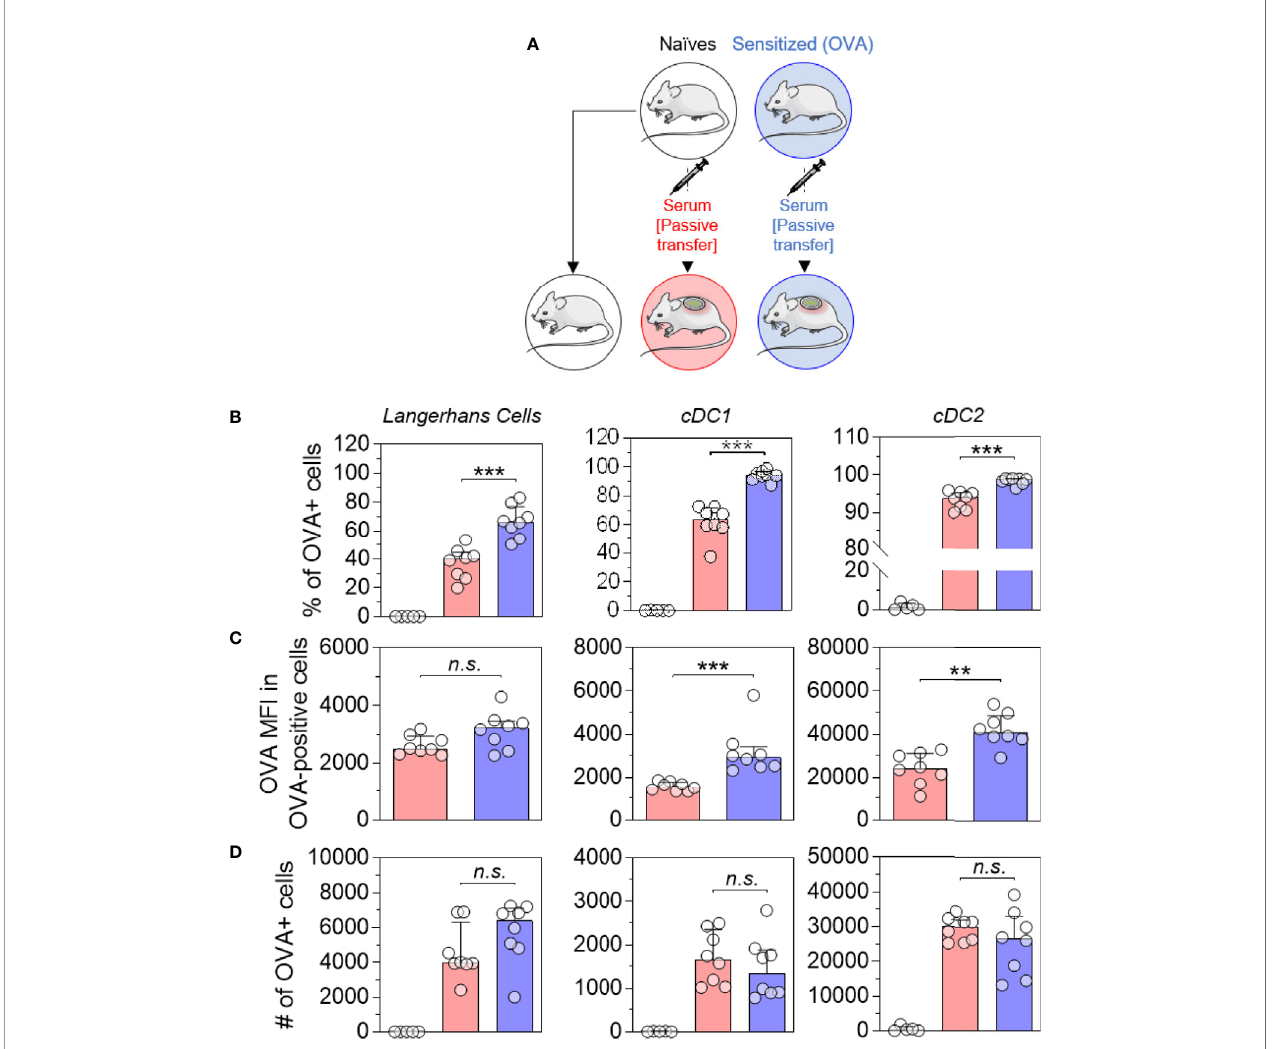
FIGURE 2 | Allergen-speci fi c humoral immunity increases the local uptake of allergen by skin DCs. (A) Mice received pooled sera obtained from OVA-sensitized mice (in blue) or naive mice (in red), as indicated. The next day, recipient mice received a patch containing OVA-AF-488 on depilated areas of the back. As a negative control for Flow Cytometric analysis, a group of naïve mice was kept untreated (in white). Six hours after patch application, a skin sample corresponding to the patch application area was collected and cells were analyzed by Flow Cytometry. (B) The percentage of OVA positive cells was measured among Langerhans cells, cDC1 and cDC2, as indicated. (C) The median of OVA fl uorescence intensity (OVA MFI) was measured from OVA-positive cells. (D) The absolute number of OVA-positive DC was calculated based on the percentages of OVA-positive cells and the total number of cells in each DC subset. Data are median and interquartile ranges of individual values (N = 8 per experimental group). Data are representative of several independent experiments. P values were determined using the Mann-Whitney test (**P < 0.01; ***P < 0.001; n.s., non-signi fi